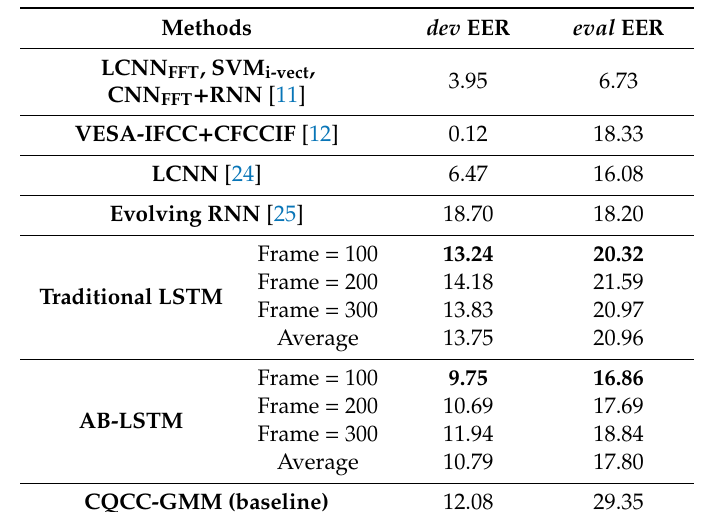
Table 2. Performance of our algorithm and other algorithms used in the ASVspoof 2017 challenge. Results are in terms of the replay / non-replay EER